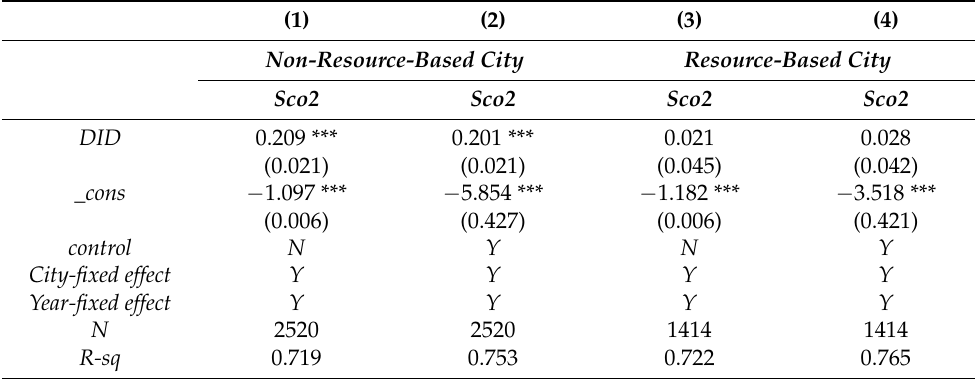
Table 8. Heterogeneity of Urban Resource Endowments.